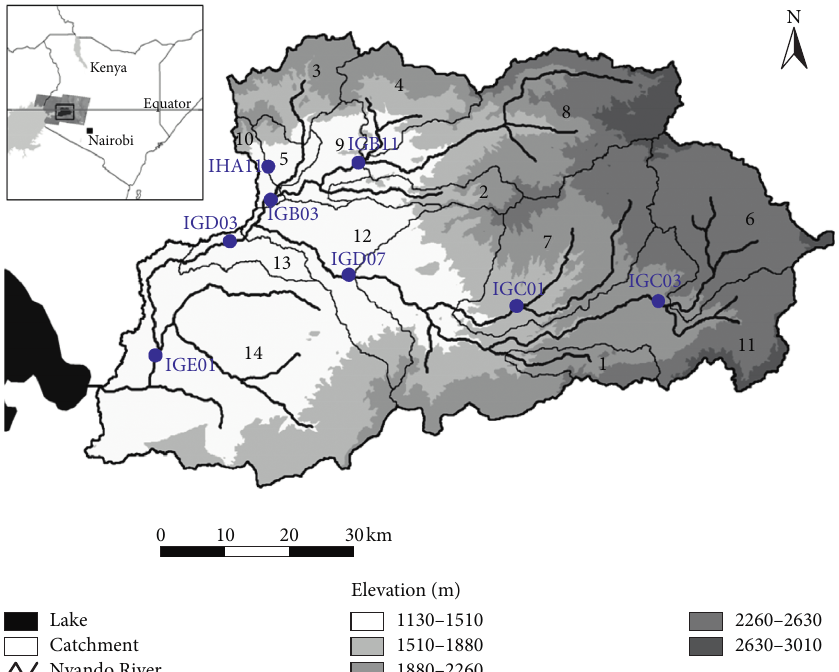
Figure 1: Location map of Nyando River basin [38], the sub-basins (1–13), and study sampling